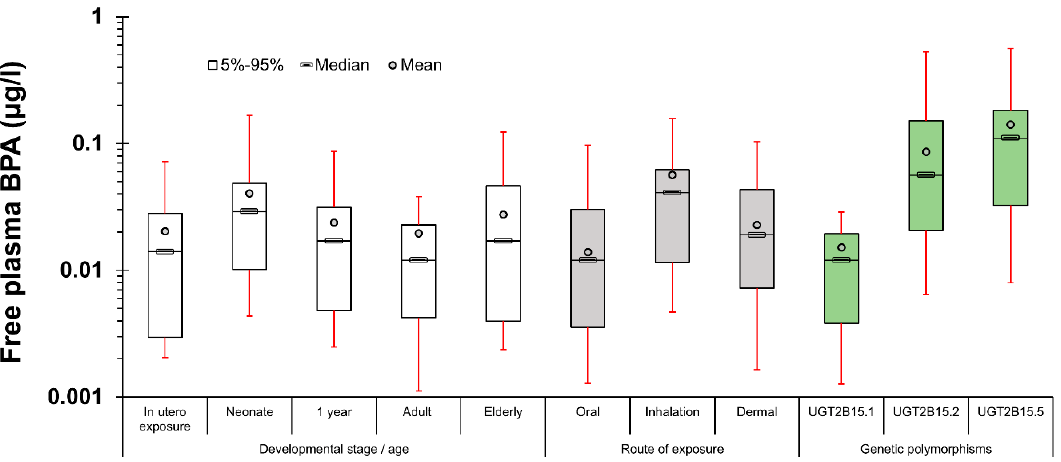
Figure 5. Understanding the major parameters inducing bioavailability differences.